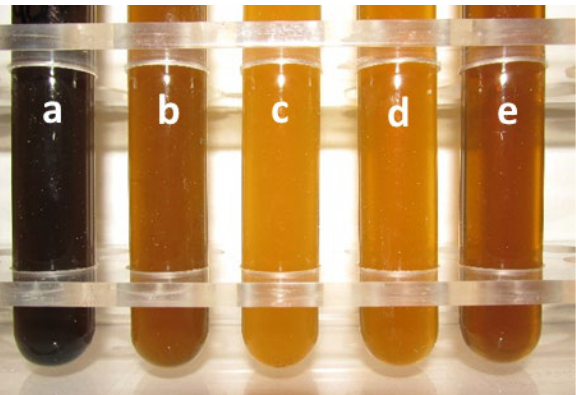
Figure 8. Visual changes in the quality of the liquid fraction of the digestate after successive stages of purification (a—liquid raw digestate; b—solution A (after struvite precipitation); c—solution A after FO with 0.5 mol/dm 3 NaCl; d—solution A after FO with 1 mol/dm 3 NaCl; e—solution A after FO with 3 mol/dm 3 NaCl).